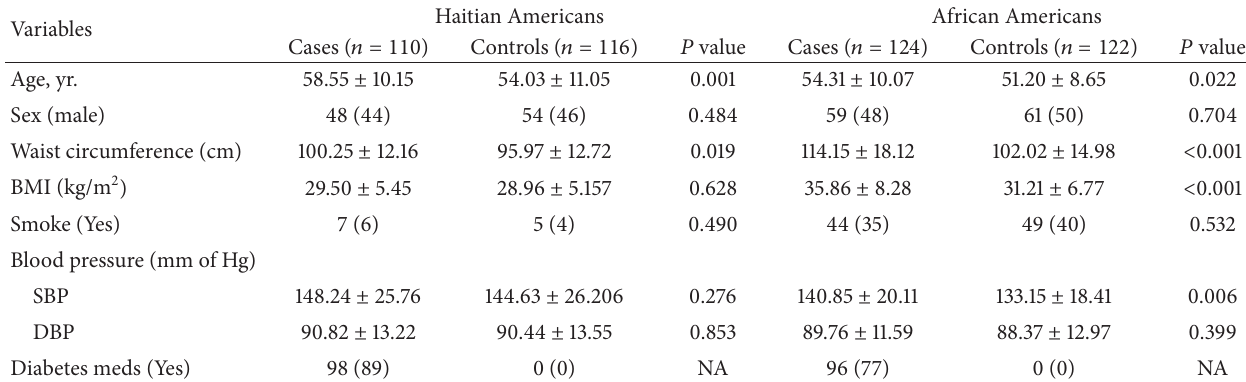
Table 2: Descriptive characteristics of individuals by ethnicity and T2D